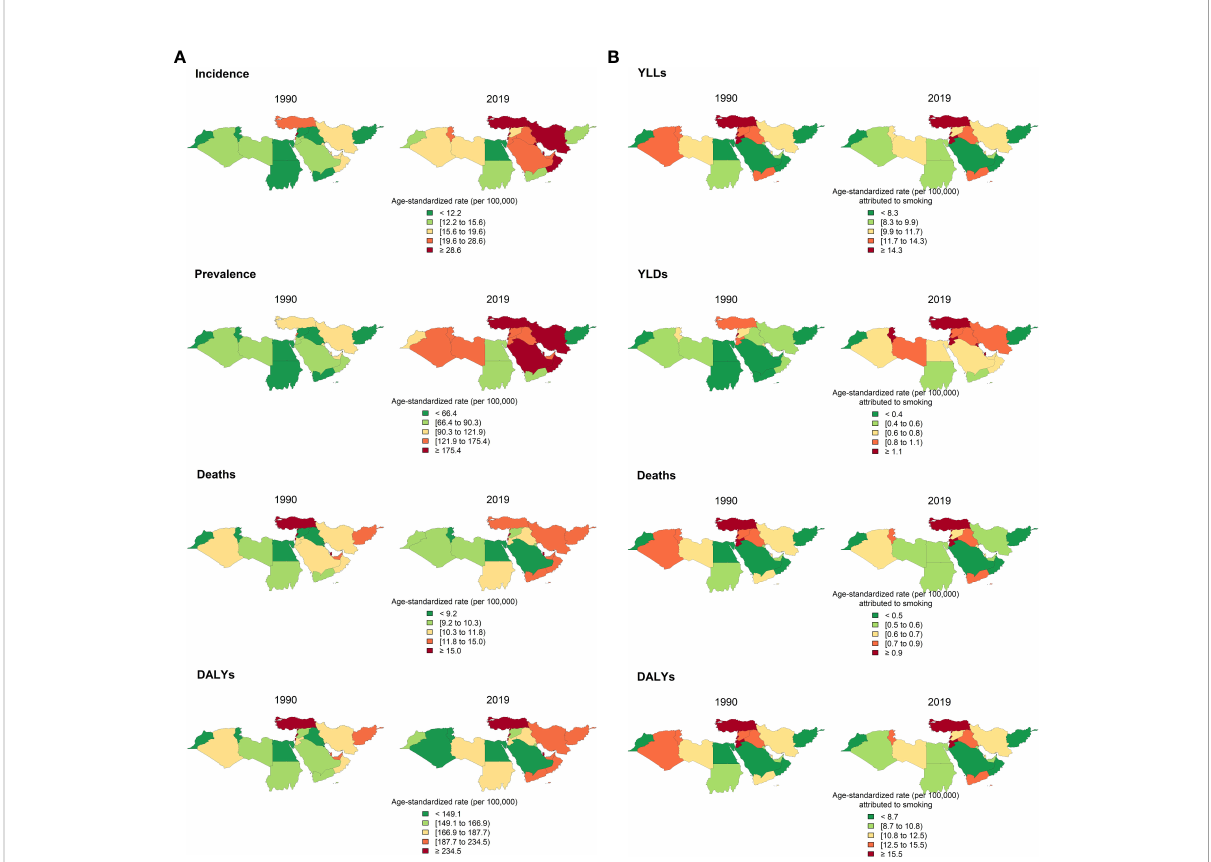
FIGURE 3 Distribution of epidemiological measures of prostate cancer by countries in 1900 and 2019: incidence, prevalence, death, and DALYs due to prostate cancer in 1990 and 2019 (A) ; YLLs, YLDs, deaths, and DALYs of prostate cancer attributable to smoking in 1990 and 2019 (B)